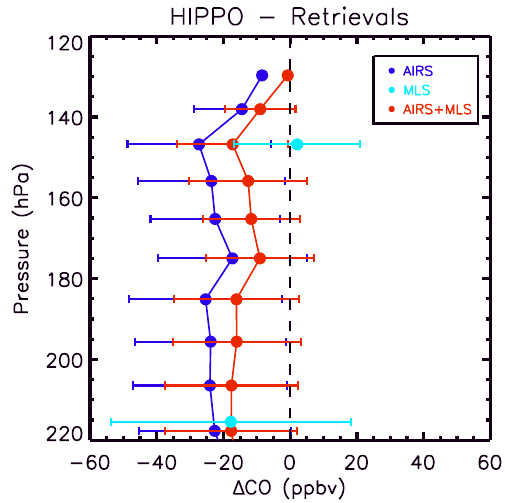
Fig. 12. Validation of the combined AIRS and MLS CO VMRs (ppbv) (red lines) in the UTLS region using HIPPO (HIPPO – Retrievals) with 1-sigma SDVs, compared with AIRS CO VMRs (ppbv) (blue lines). Positive differences indicate that the data fusion approach works well in the UTLS regions with an error reduction of approximately half at most levels.